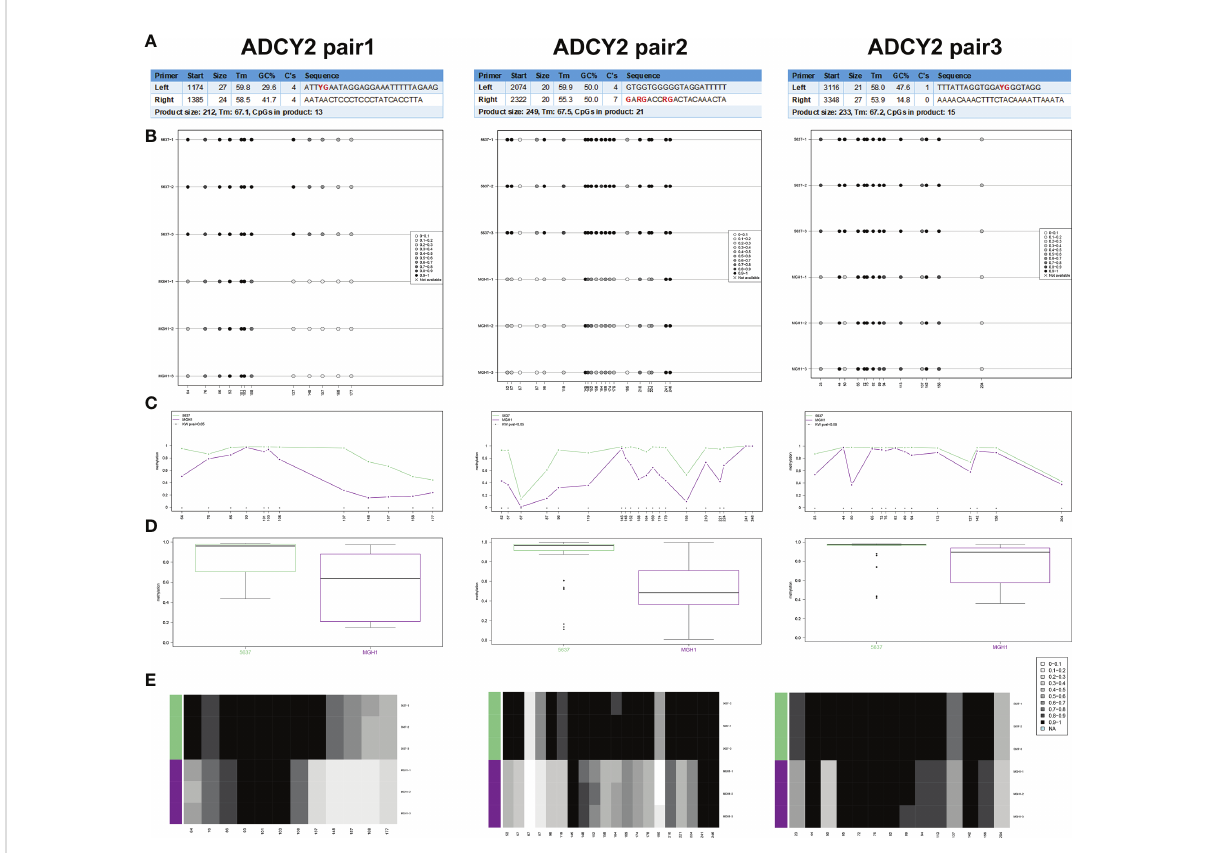
FIGURE 8 Identi fi cation of promoter regions of ADCY2 methylation in BCa cells using BSAS technology. (A) The effectiveness of ADCY2 primers was developed and veri fi ed in human BCa 5637 and MGH1 cells using BSAS technology. The three pairs of primers for ADCY2 methylation were shown, and the CG site of the ampli fi ed fragment was indicated in bold and red. (B) The schematic diagram of the average methylation information of all sites in the 5637 and MGH1 cells. (C – E) The methylation levels of all sites in the grouped samples were shown in boxplots and